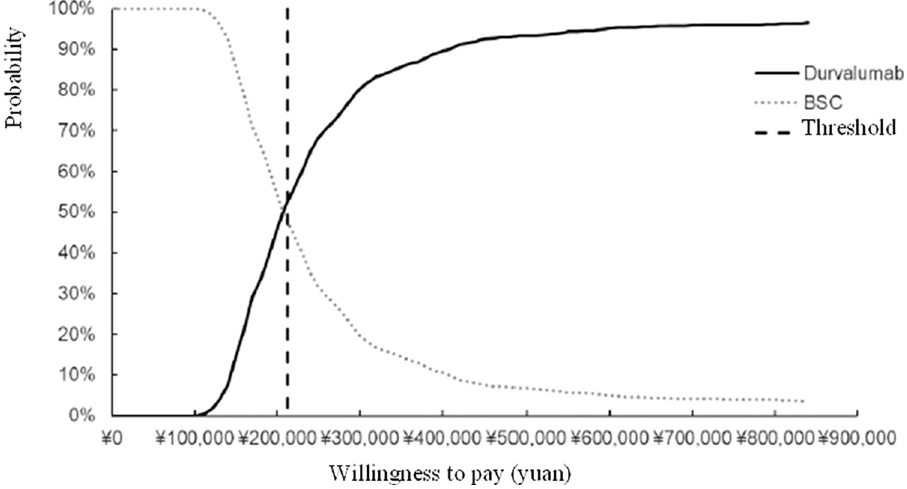
Fig 4. Cost-effectiveness acceptable curve. The acceptability curve shows the probability of a treatment being cost- effective over a range of willingness-to-pay thresholds. The curve shows that BSC is the most likely to be cost-effective until a willingness-to-pay threshold of 200,000 yuan is reached, after which durvalumab is most likely to be cost-